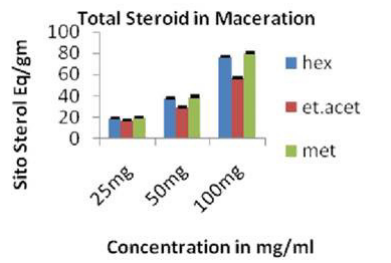
Fig. 3. Total phenolic content in maceration